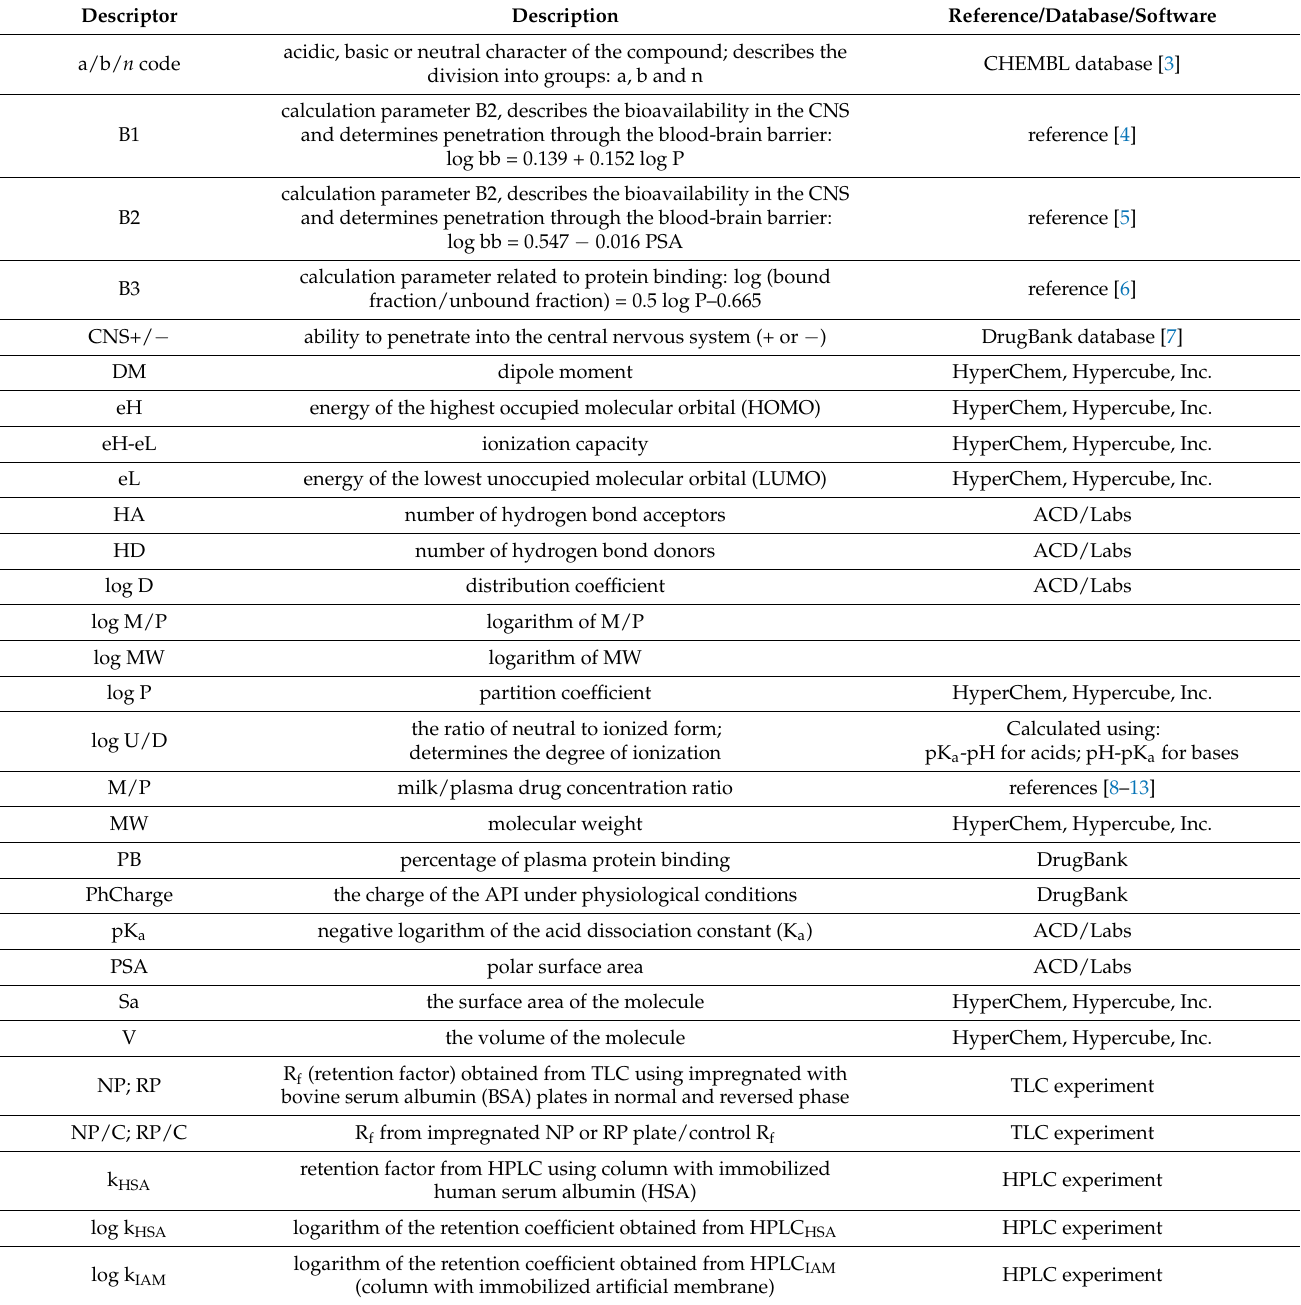
Table 1. List of molecular and chromatographic descriptors used in statistical